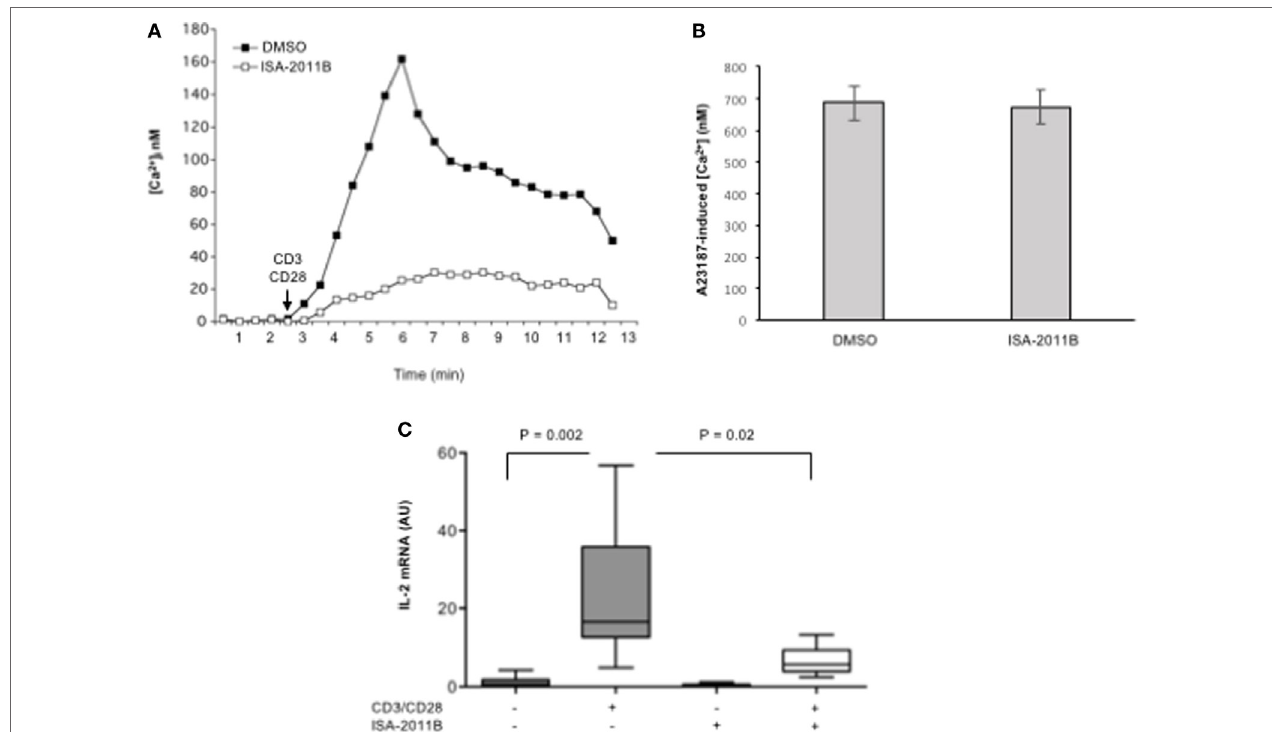
FigUre 4 | isa-2011B impairs Tcr- and cD28-induced increase of [ca 2 + ] i and il-2 gene expression in primary T cells . (a,B) Primary T cells from HD were treated for 6 h with DMSO or ISA-2011B (10 µM) and after loading T cells with Fluo-3-AM, Ca 2 + levels ([Ca 2 + ] i ) were measured by cytofluorimetric analysis after stimulation with crosslinked anti-CD3 plus anti-CD28 Abs (a) or A23871 (2 µg/ml) for 10 min. Data are representative of three independent experiments. (c) Real-time PCR was used to measure IL-2 mRNA levels in primary T cells from healthy donors ( n = 5) treated with DMSO or ISA-2011B (10 µg/ml) and stimulated for 6 h with crosslinked anti-CD3 plus anti-CD28 Abs. Values, normalized on GAPDH, are expressed as arbitrary units. Median values: DMSO = 0.55; DMSO CD3 plus CD28 = 16.59; ISA-2011B = 0.25: ISA-2011B CD3 plus CD28 = 5.68. Lines represent median values and P values are indicated where significant